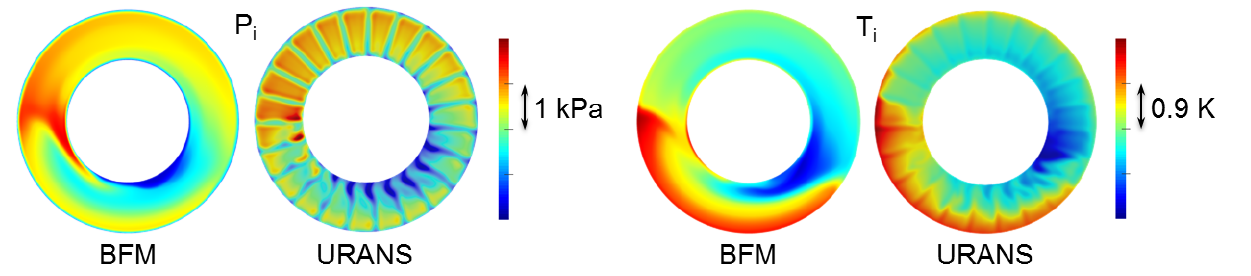
Figure 12. Total pressure ( left ) and total temperature ( right ) downstream of the stator.